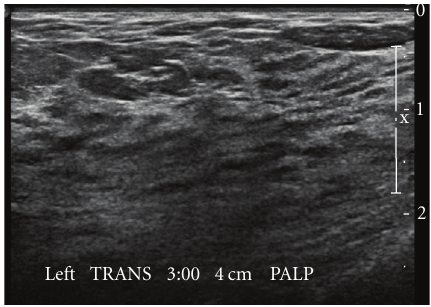
Figure 3: (a) Lymphocytic lobulitis and ductitis with glandular atrophy. Dense fibrosis. (b) Lymphocytic lobulitis, higher magni-